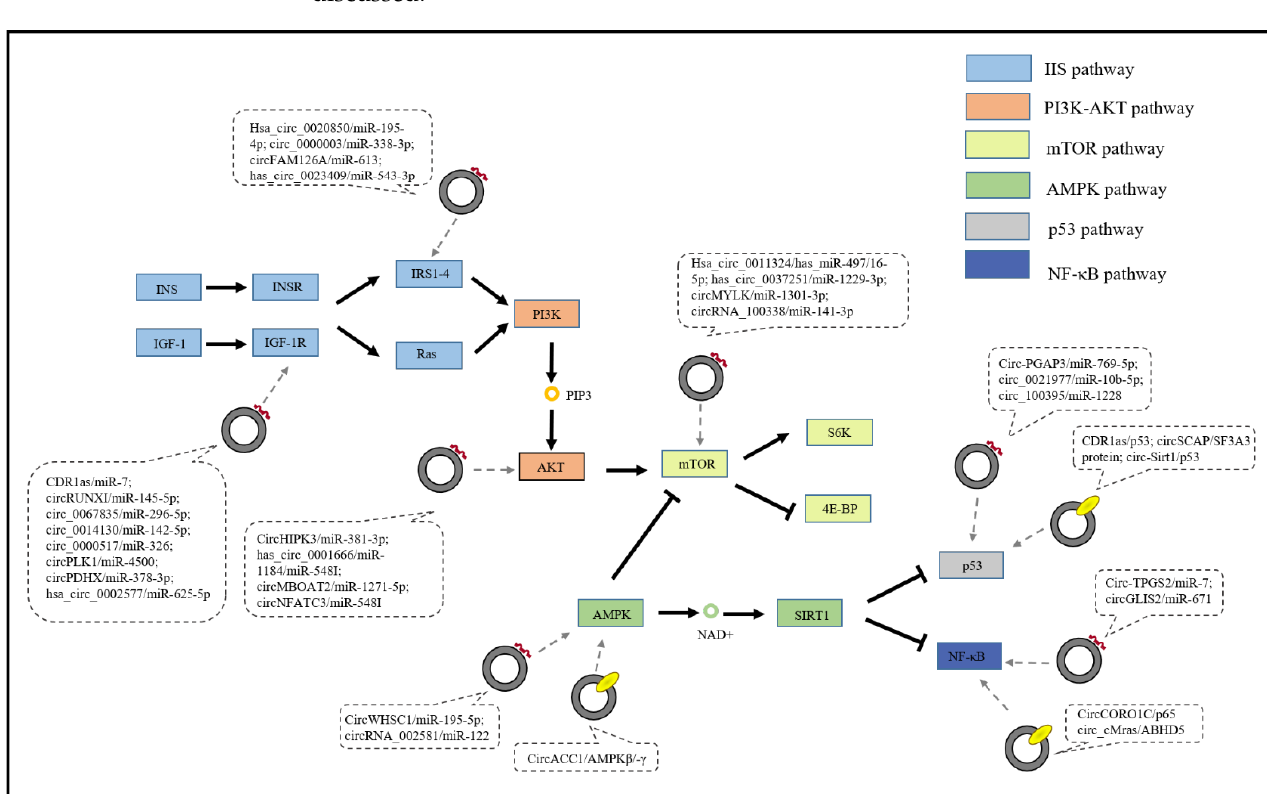
Figure 3. An overview of circRNAs involved in the regulation of age-related signaling pathways. CircRNA/miRNA indicates circRNAs that act as miRNA sponges, circRNA/protein indicates circRNAs that directly bind to proteins, and circRNA/mRNA indicates circRNAs that regulate the transcription of mRNA.